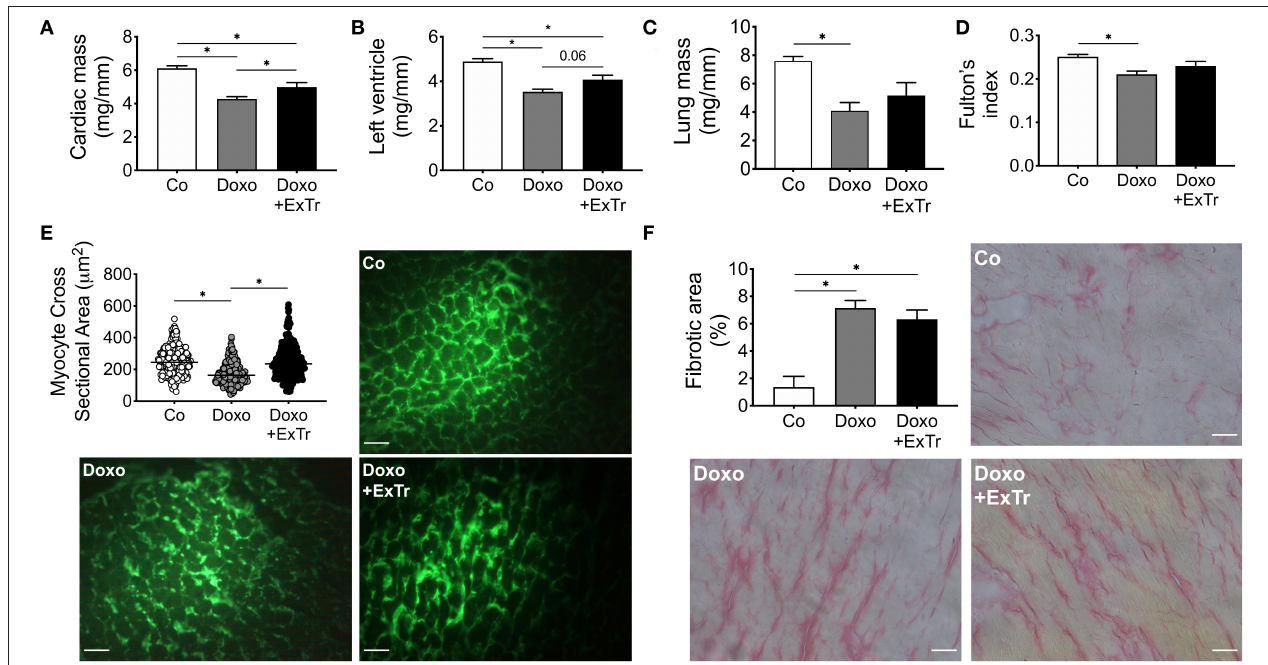
FIGURE 3 | ExTr alleviates Doxo-induced cardiopulmonary atrophy. Doxo induces cardiac (A) , left ventricle (B) , and lung (C) mass atrophy (normalized by tibia length and expressed in mg/mm), which is alleviated by ExTr. Fulton’s index (RV/LV + S) reduces with Doxo and is partially preserved by ExTr (D) . ExTr prevents cardiomyocyte atrophy induced by Doxo (E) . Doxo increases cardiac collagen deposition that is not prevented by ExTr (F) . Group abbreviations as in Figure 1 . N = 8–11 (A–D) , > 500 cardiomyocytes pooled from n = 2–3 (E) and n = 5 (F) per group. * P ≤ 0.05.